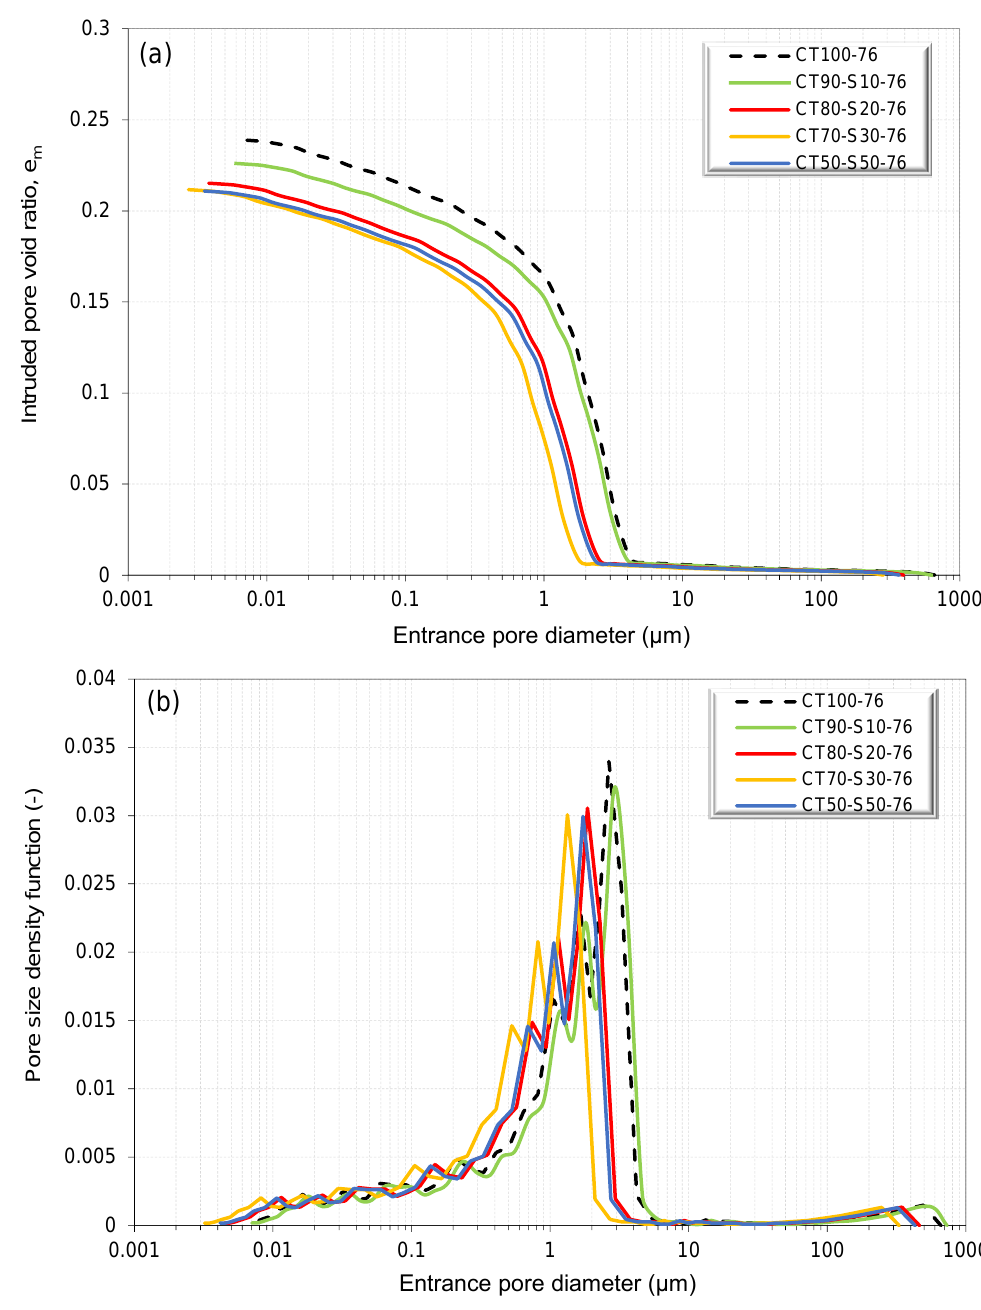
Figure 6. MIP results of 76 wt.% solid fill specimens: ( a ) cumulative; ( b ) incremental curves.